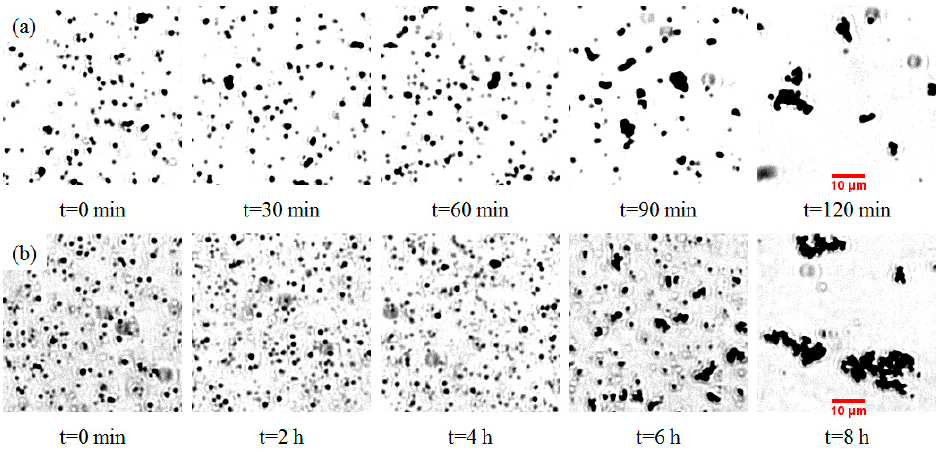
Figure 1. Microscopic images of ultra-violet (UV) light–induced aggregation of ( a ) rutile submicron particles over 120 min and ( b ) anatase submicron particles over 8 h in deionized (DI) water.